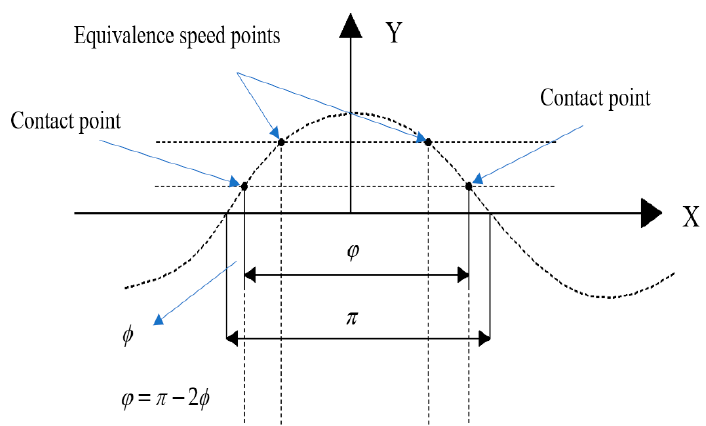
Figure 3. Schematic diagram of the contact model.